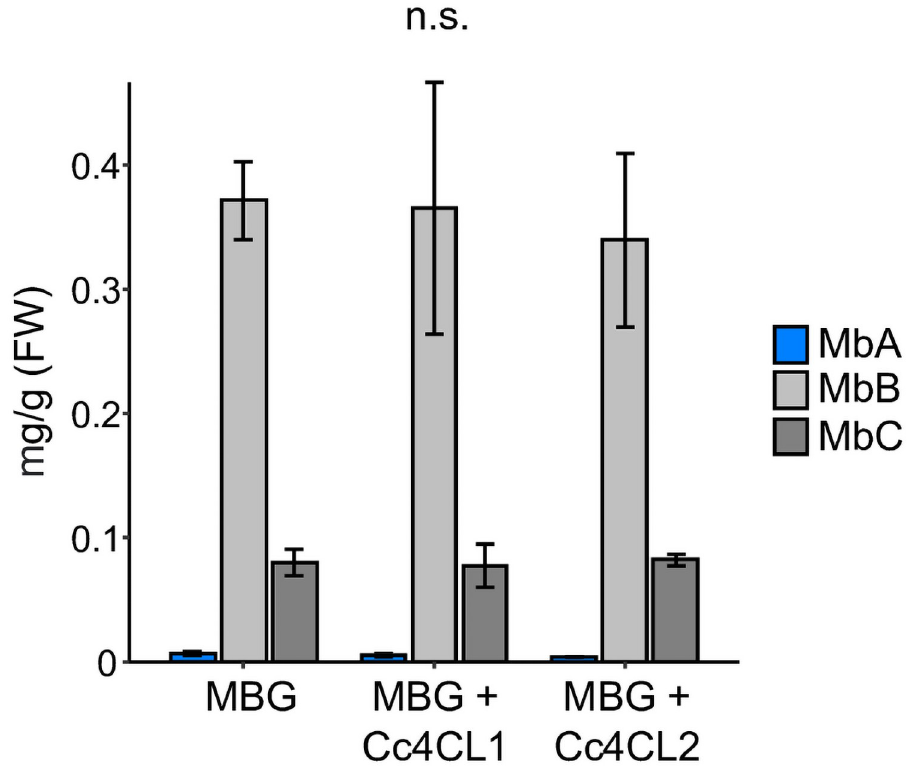
Fig 5. Montbretin accumulation in N . benthamiana co-expressing MbA biosynthetic genes and Cc4CL1 or Cc4CL2. N . benthamiana leaves were infiltrated with different combinations of A . tumefaciens transformed with plasmids carrying the 35S -promoter-gene constructs for myricetin and MbA biosynthetic genes (= MBGs, [6]) as well as 4CL1 or 4CL2 (see S6 File). Leaves were collected 5 days post-infiltration. Metabolites were extracted with 50% MeOH, analyzed by LC-MS. Data represents mean ± SE (n = 4). MbA (F 8,18 = 1.57, p = 0.204), MbB (F 8,18 = 1.43, p = 0.25), MbC (F 8,18 = 1.06, p = 0.43), n.s. not significant.